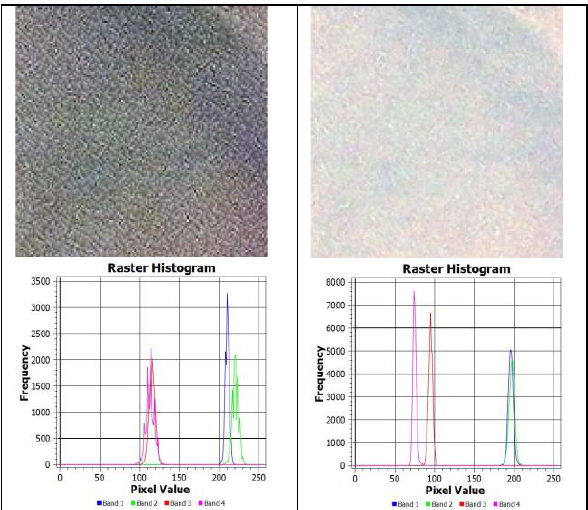
Figure 11. MAXAR 30 cm (left) and 15 cm (right) image parts over water surface in Munich.